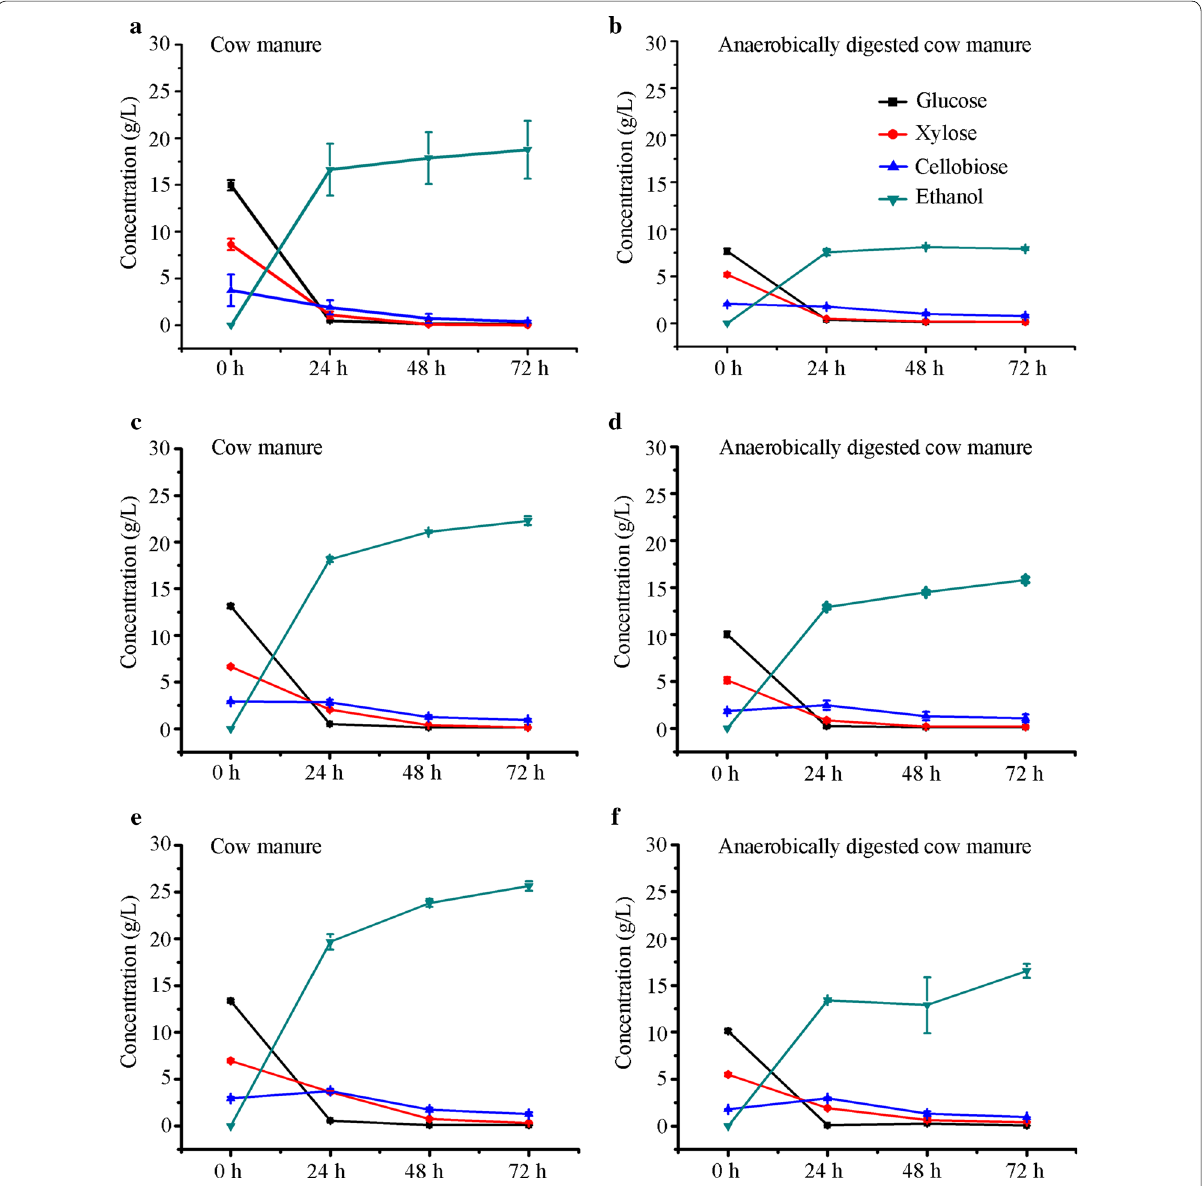
Fig. 4 Batch and Fed-batch enzymatic hydrolysis with SN-1 and ethanol production. Batch enzymatic hydrolysis at an initial solid loading of 15% ( a , b ). Fed-batch enzymatic hydrolysis at an initial solid loading of 10%, and the final 15% ( c , d ) and 20% ( e , f ) biomass of fed-batch supplement were